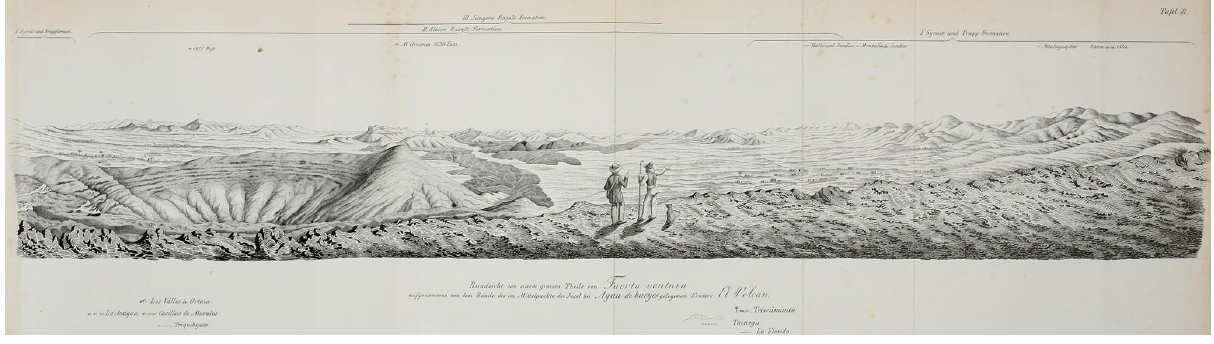
Figure 4. Hartung (1857b), plate III, depicting a panoramic view of Fuerteventura (Canary Islands) from the locality of Agua de Bueyes. The image is public domain and was digitalized by the Biodiversity Heritage Library (https://www.biodiversitylibrary.org/item/46730#page/ 320/mode/1up, last access: 26 September